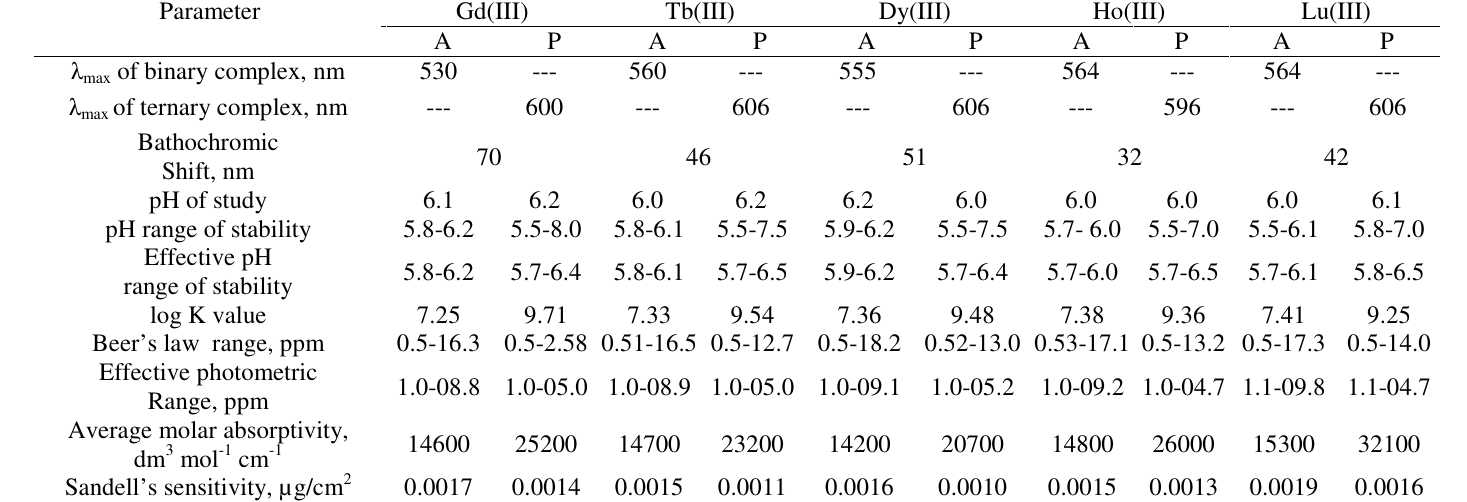
of ECR at pH 6.0 = 432 nm. max